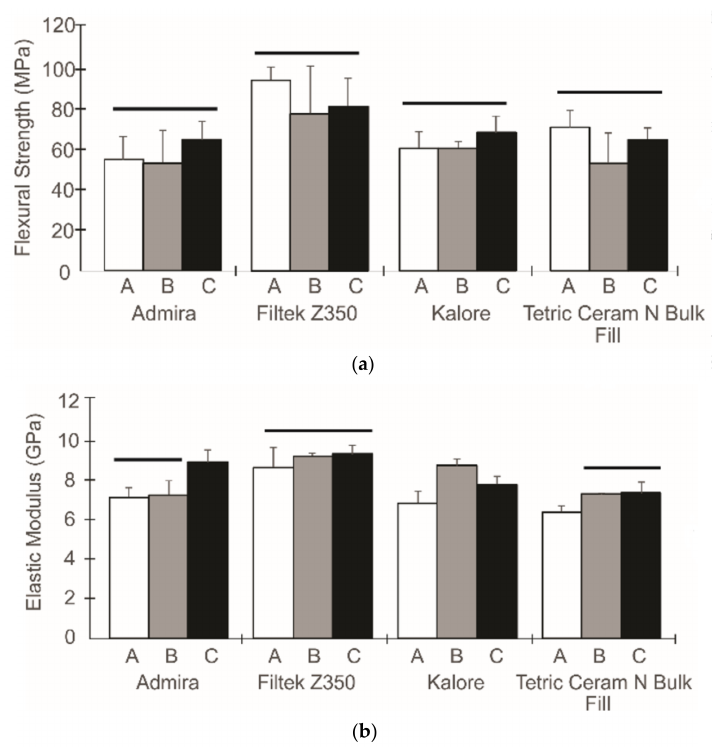
Figure 1. The flexural strength ( a ) and the elastic modulus ( b ) from different curing protocols. The columns under the same horizontal line are not statistically different.